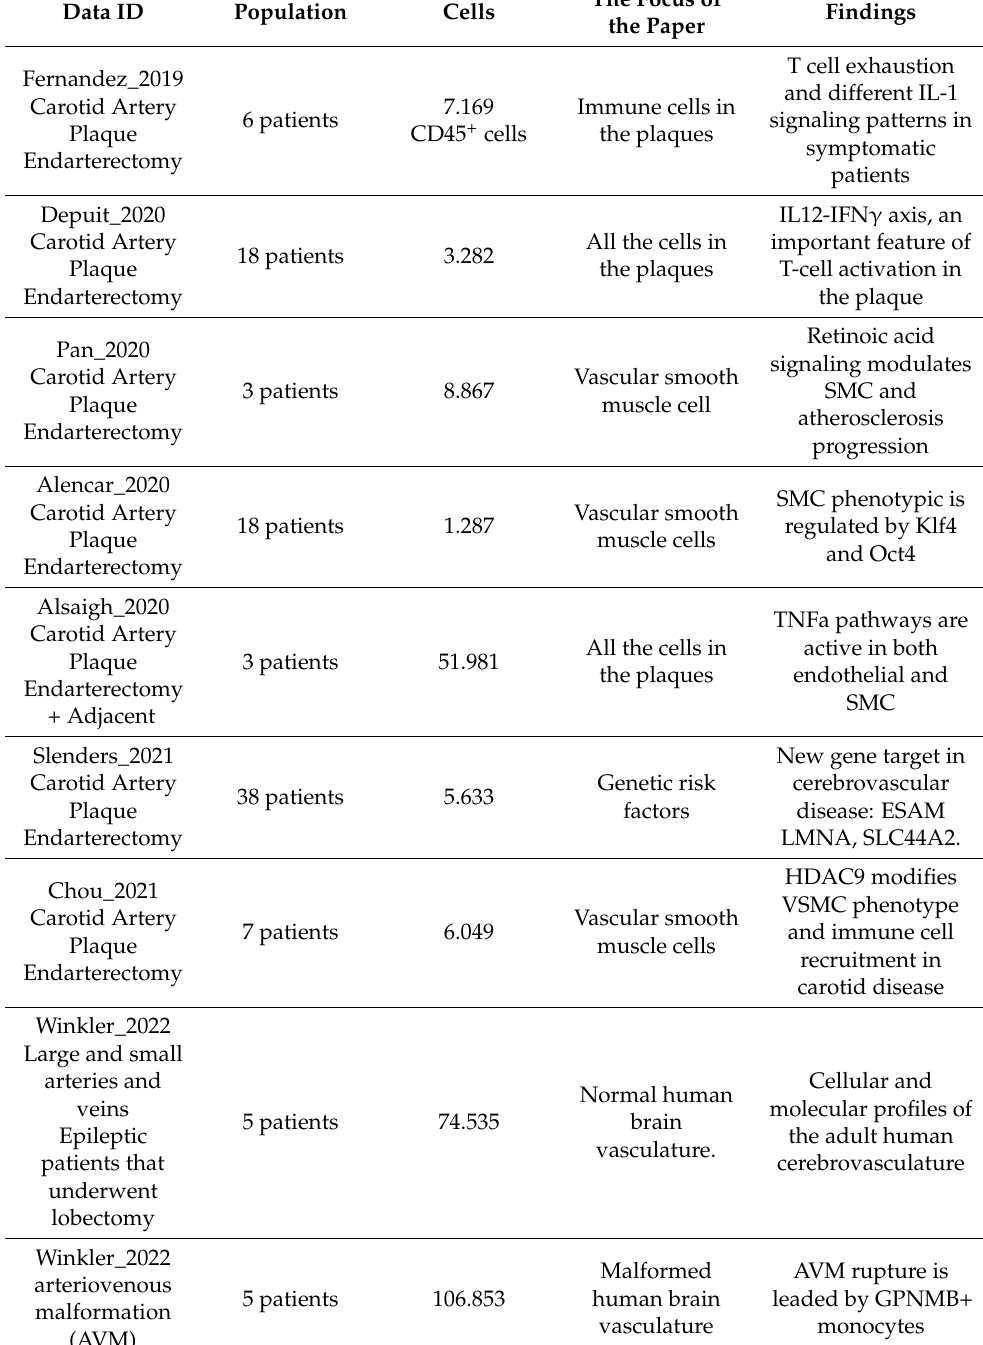
Table 1. Single cell RNA seq analysis in human cerebral vessels and atherosclerotic